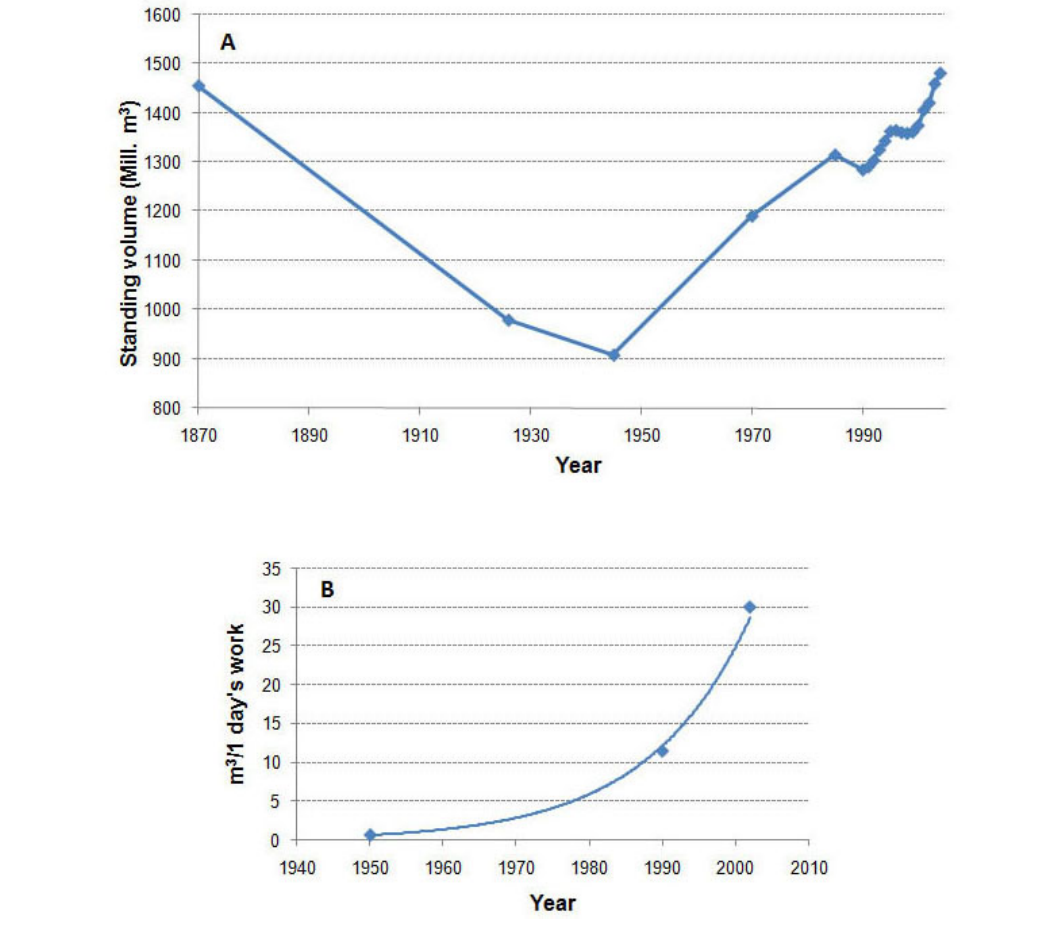
Fig. 2 . A. Changes in the standing volume of timber summed over the five northernmost counties in Sweden. Data from 1870 from Linder and Östlund (1992), other data from the Swedish National Forest Inventory (SOU 2001:101). The data before 1990 are averages, while the data after 1990 are moving 5- year